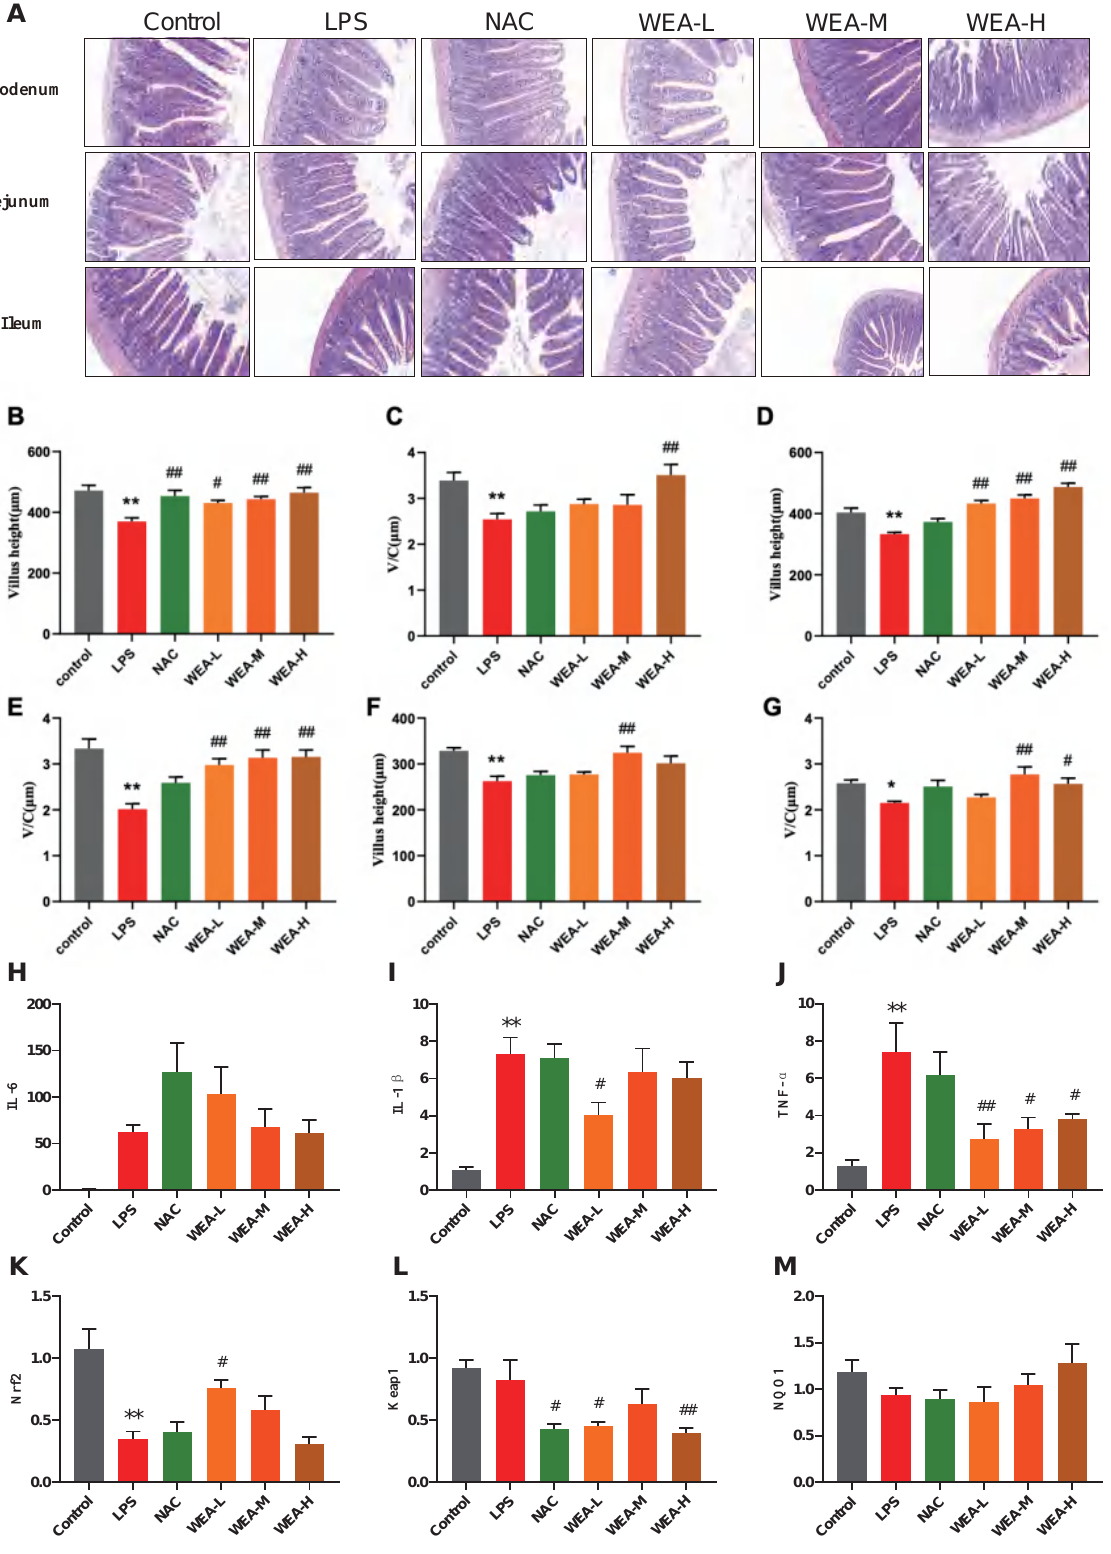
Figure 6. Intestinal morphology of mice and gene expression of pro-inflammatory and Nrf2-related genes of duodenum in mice. ( A ) Representative images of duodenum, jejunum, and ileum histology; all captured at 200 × magnification. ( B ) Duodenum villus height and ( C ) ratio of villus height to crypt depth; ( D ) jejunum villus height and ( E ) ratio of villus height to crypt depth; ( F ) ileum villus height and ( G ) ratio of villus height to crypt depth. ( H ) IL-6, ( I ) IL-1 β , and ( J ) TNF- α expressions in the